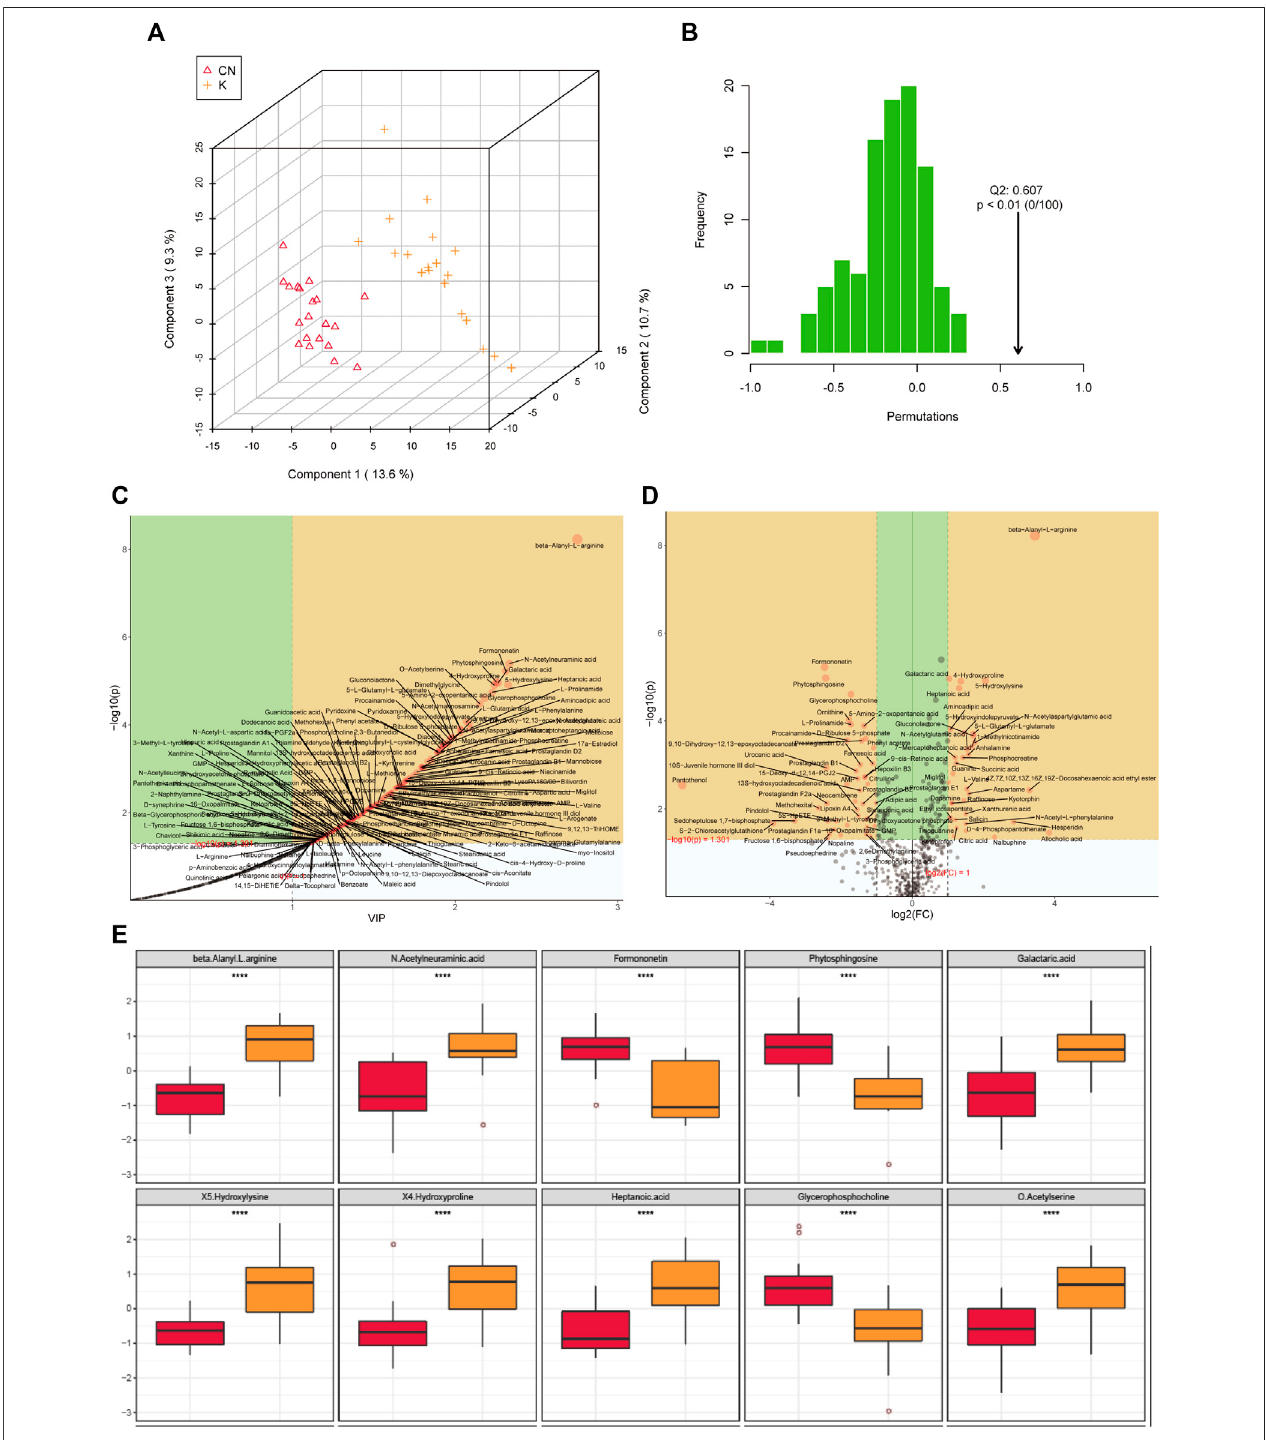
FIGURE4|(A) Eachpointcorrespondstoasample,andthehorizontalandverticalcoordinatesarethevaluesofthetwofactorswiththebestdiscriminationeffect. Different groups are marked with different colors, and the area marked by the ellipse is the 95% con fi dence area of the sample point. (B) The abscissa represents the distribution interval of the replacement test statistic (model prediction accuracy), the ordinate is the frequency of the test statistic in the interval during the replacement process,andthepositionpointedtobythearrowistheobservedteststatisticvalue.Ifthisvalueisfarfromtherandomdistribution,themodeldistinguishingeffectis not random, and the model distinguishing effect is signi fi cant. (C) PLS-DA metabolite importance map. In the fi gure, each point represents a metabolite, the abscissa is VIP (value importance in projection), and the ordinate is the p value after FDR correction (log10 conversion). (D) Multiple change volcano map. Each point represents a